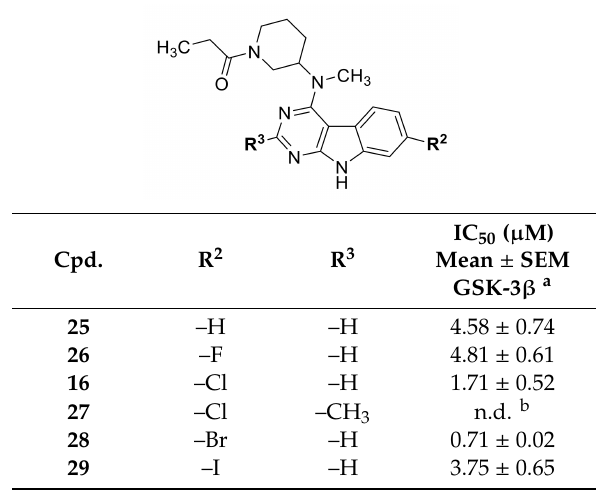
Table 3. Structures and biological activities of compounds 16 and 25 – 29 .